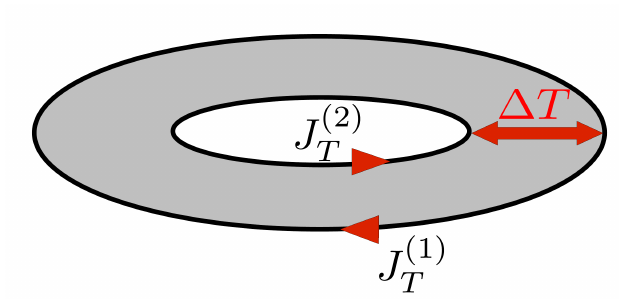
Figure 7: Annular geometry with the two edges at different temperatures and their thermal